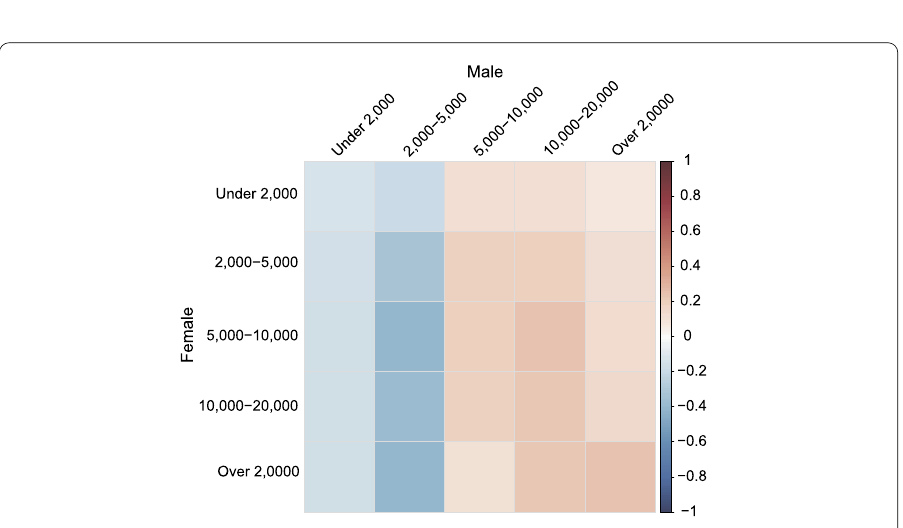
Figure 8 Preference for monthly income levels for female users sending messages to male users. The vertical axis indicates the female income levels and the horizontal axis indicates the male income levels. Preference values are represented by different